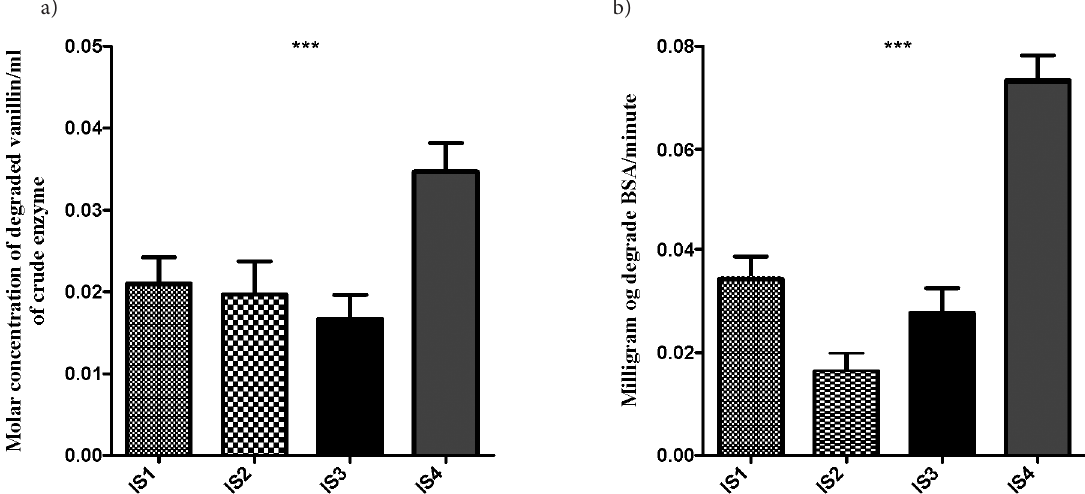
Figure 3. Observation of lipolytic and proteolytic activities of the isolates: a) Graphical representation showing the amount of lipid degraded activity by the microorganisms which was determined by the concentration of the vanillin degraded per ml of the crude enzyme. Y-axis indicates the molar concentration of degraded substrate per ml of enzyme and the X-axis denotes the test isolates; b) Graphical representation showing the protease activity by the microorganisms which were determined by milligram of degraded BSA per minute. Y-axis indicates the amount of degraded substrate per minute and the X-axis denotes the test isolates. All the data (n = 3) are illustrated in the bar diagram as mean +SD. ***p < 0.0001 as determined by One-way ANOVA (IS1 to IS4 represents the isolates; BSA: Bovine Serum Albumin)